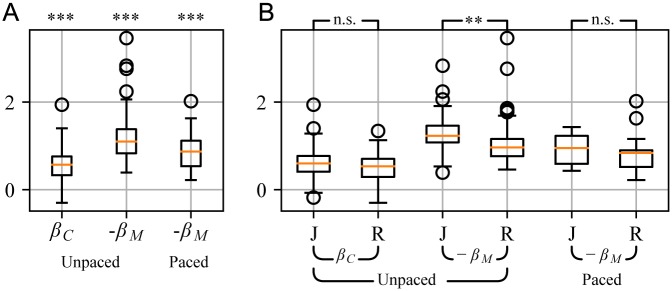
Scaling exponents (β) obtained from analyzing the PSDs of IBI time series.A. Neither the clock nor the motor process is random but clearly long-range persistent, i.e. βC > 0, −βM < 2. *** denotes p ≪ 10−3 (significance obtained by bootstrapping). B. Genre-dependence of the scaling exponents. The motor process showed significantly stronger long-range persistence in rock/pop (R) than in jazz (J). The box plot depicts the median in red, boxes at the first and third quartile, whiskers at 1.5 ⋅ IQR (interquartile range), and circles represent outliers. ** denotes p = 0.001, and n.s. denotes not significant.